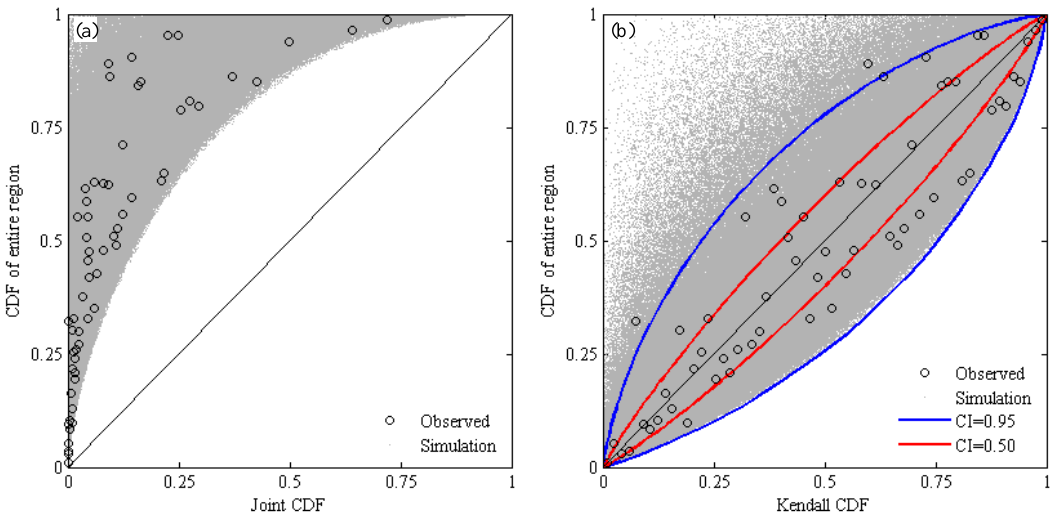
Figure 8. CDF of precipitation of the entire region responding to (a) the conventional joint CDF and (b) the Kendall CDF of eight sub-regions.